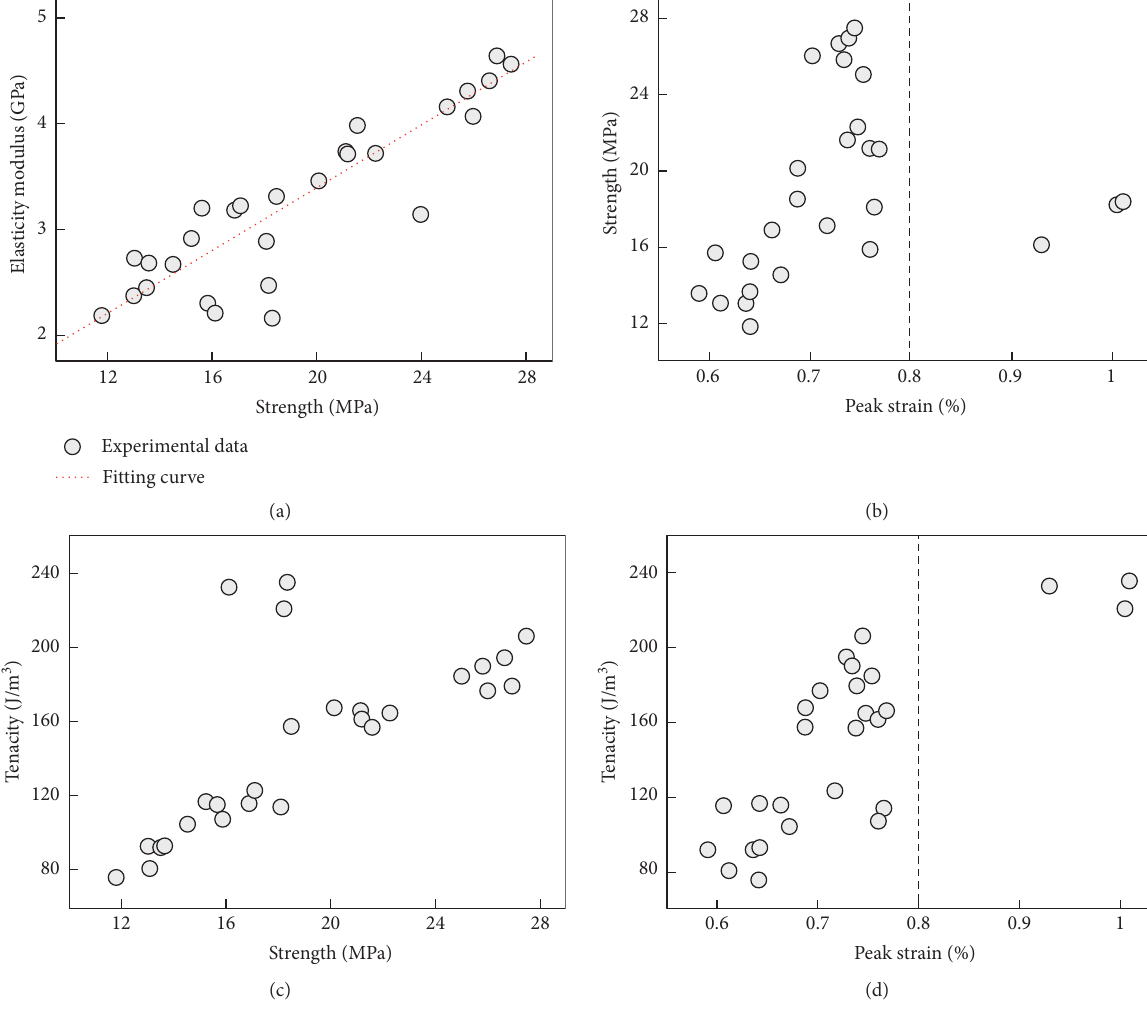
Figure 6: The strength and corresponding peak strain as a function of tenacity, elasticity modulus, and so